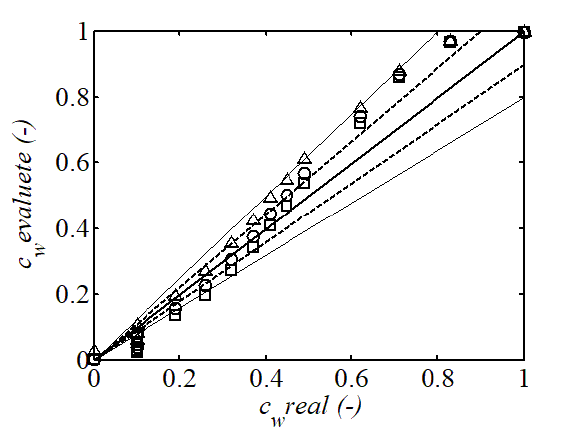
Fig. . Parity plot of relative concentration by experiment and by evaluation. Legend: square – evaluation for b w 101, circle – evaluation for b w 80, triangle – evaluation for b w 54, thick line – perfect fit, dash line – deviation 10%, thin line – deviation 20%